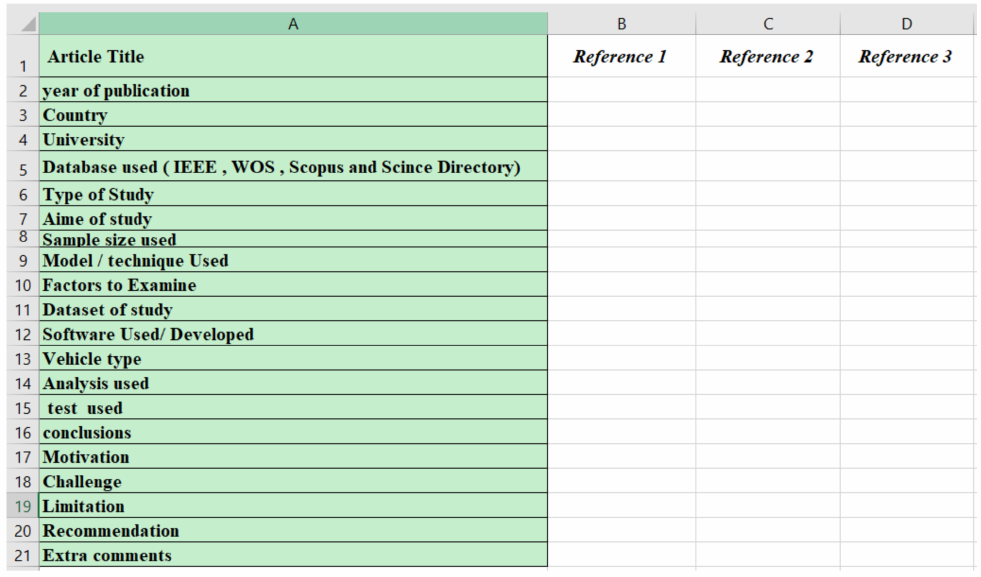
Figure 2. Scanned attributes from full-text